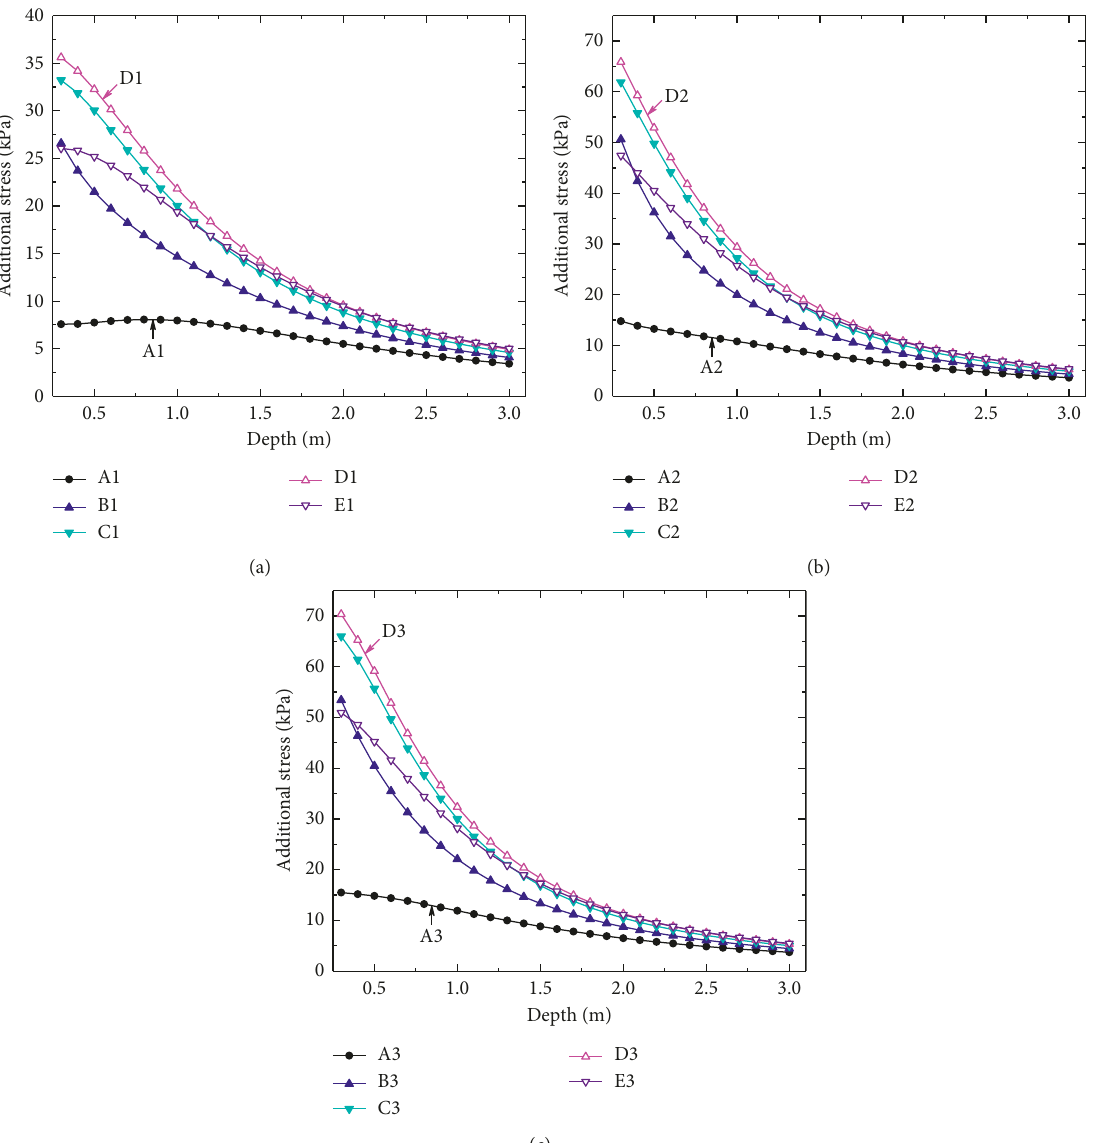
Figure 16: Additional stress directly beneath the plate bottom: (a) points A1–E1; (b) points A2–E2; (c) points